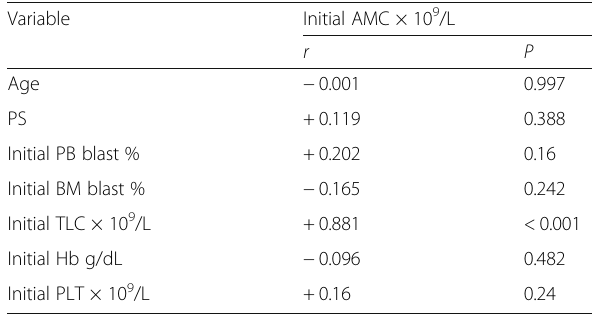
Table 2 correlation between the Initial AMCx10 9 /L and other studied